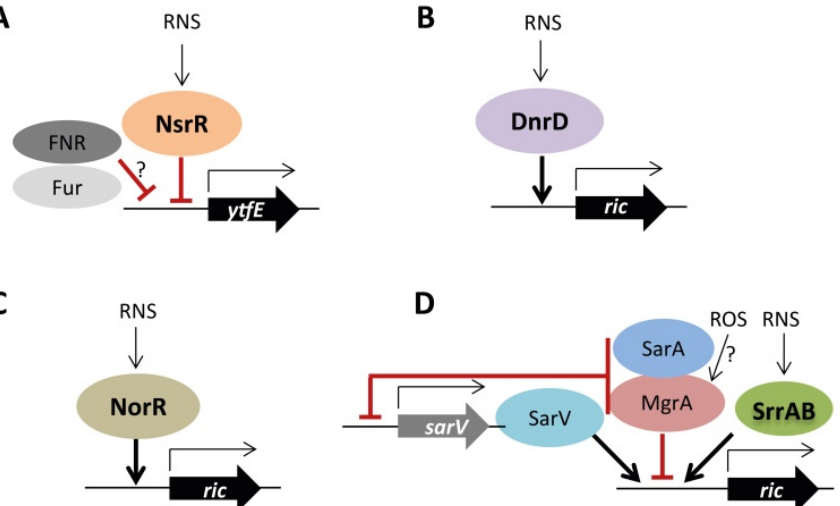
Figure 1. Regulation of ric in bacteria. ( A )— E. coli YtfE is negatively regulated by NsrR and possibly indirectly repressed by FNR and Fur. ( B )— P. stutzeri ric is under the positive control of DnrD. ( C )— R. eutropha ric is regulated by NorR. ( D )— S. aureus ric is regulated by the two-component system SrrAB in response to RNS. Adapted from